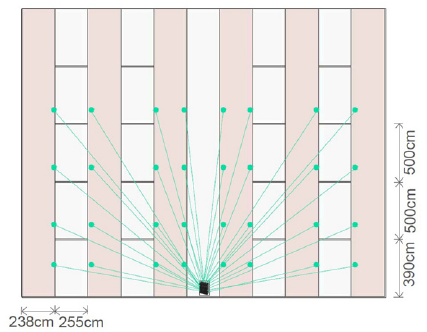
Fig. 7. Distribution of sensor nodes in steel box girder bridge (BS is placed at bottom center)